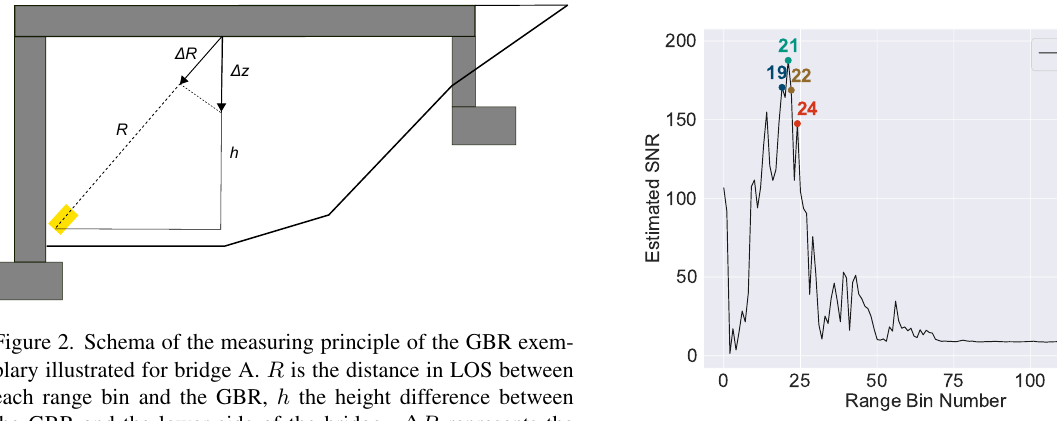
Figure 1. (a) View of bridge A recorded by a unmanned aerial vehicle. The rectangle marks the GBR position and its inclination. Crosses represent points with a high SNR. (b) A side view of the measurement setup of bridge B. The GBR and two corner reflectors are highlighted. (c) The GBR position at bridge C. No reflectors have been attached to the lower side of the bridge.